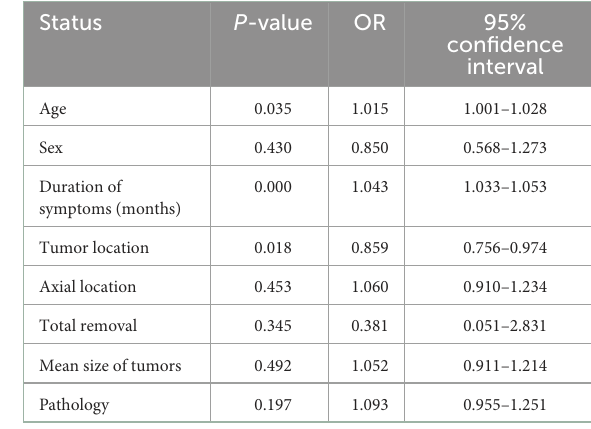
TABLE 4 Logistic regression analysis between improved and unimproved